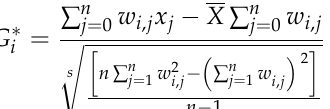
Figure 7. Variable importance using XGBoost Classifier.